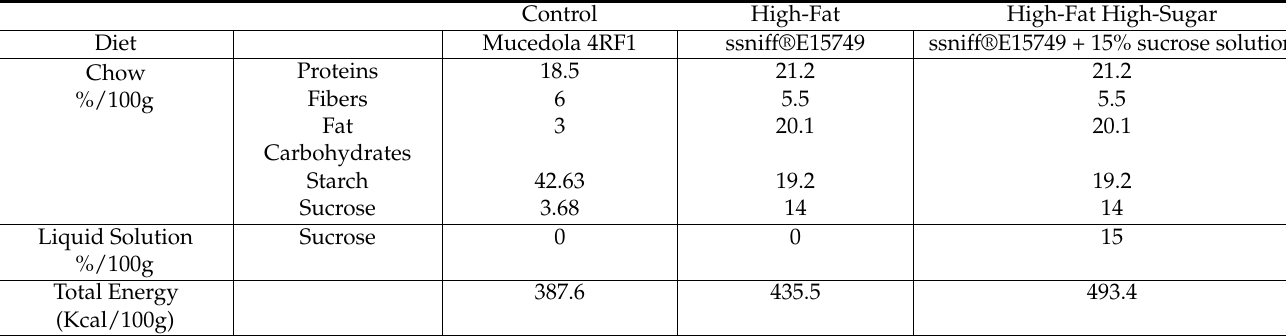
Table 1. Composition of experimental